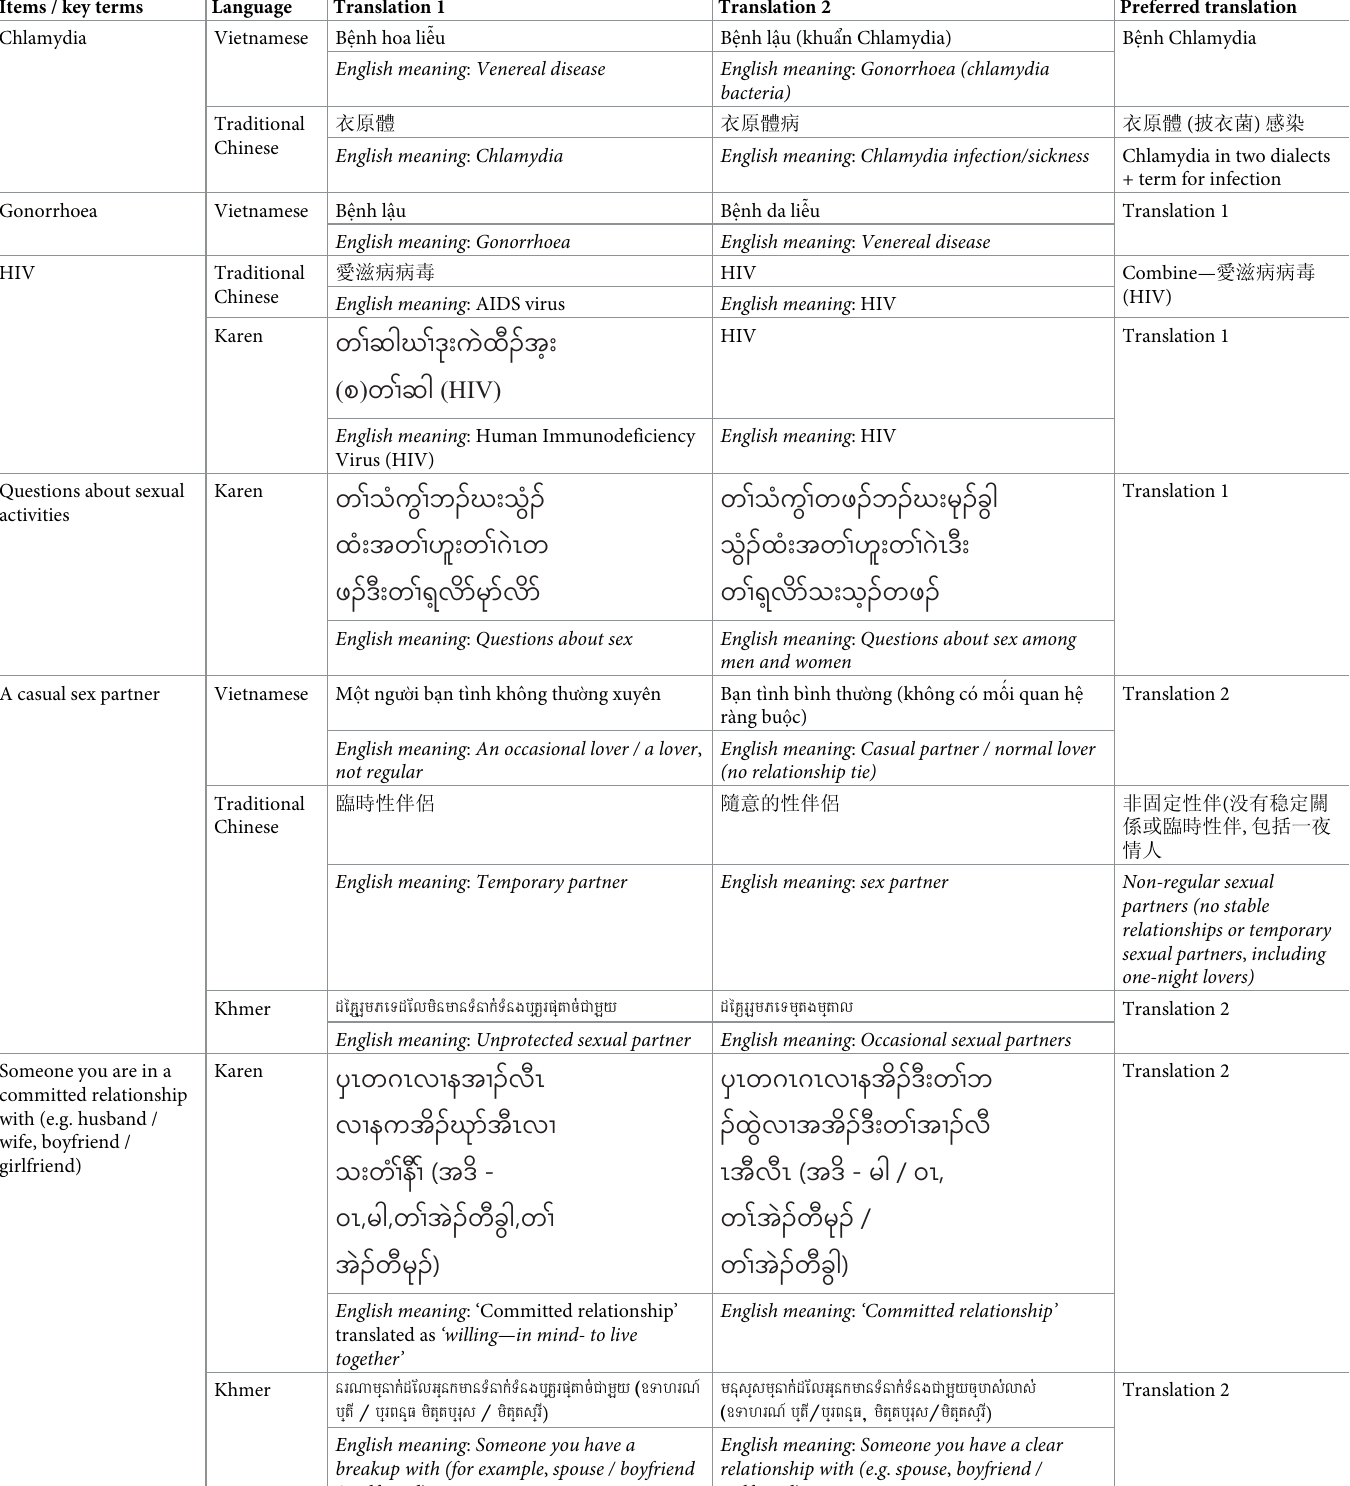
Table 4. Examples of material differences between translations detected during the review process, and outcome of